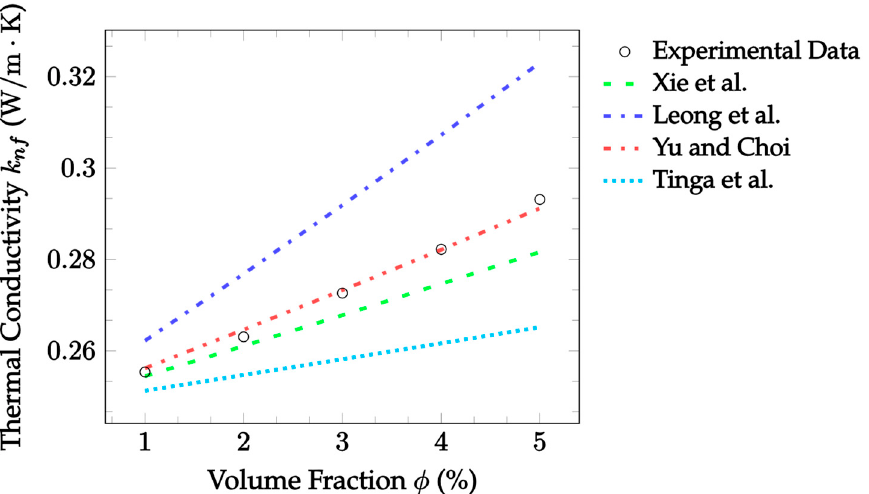
Figure 7. Nanolayer nanofluid thermal conductivity predictions compared with data for Al 2 O 3 –EG nanofluid at 27 °C and with a particle diameter of 24.4 nm: Experimental Data [12], Xie et al. [26], Leong et al. [25], Yu and Choi [27], Tinga et al. [28].